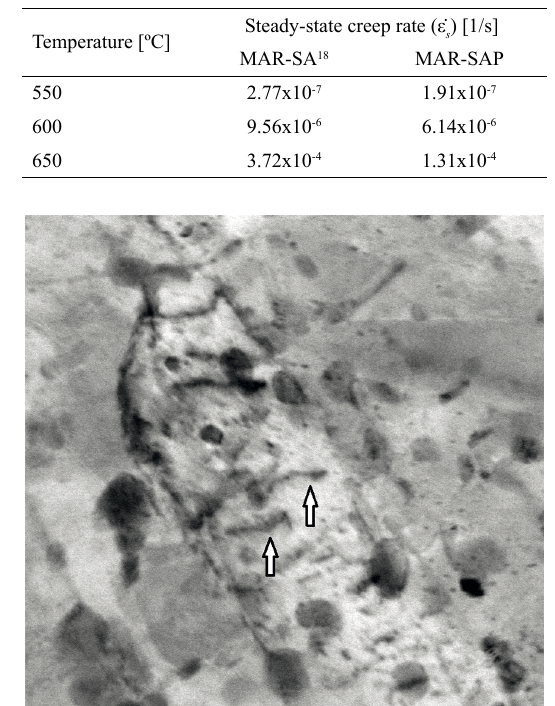
) of MAR-SA 18 and MAR-SAP s